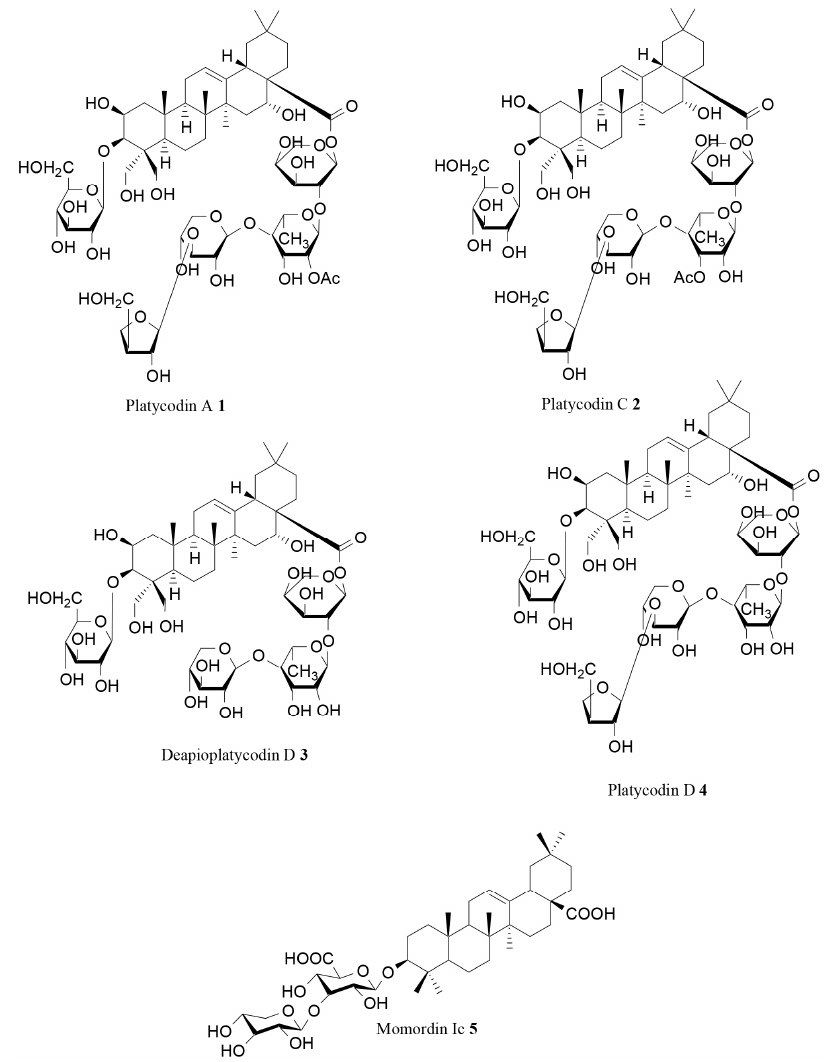
Figure 2. Structure of some saponins with inhibitory effects on pancreatic lipase